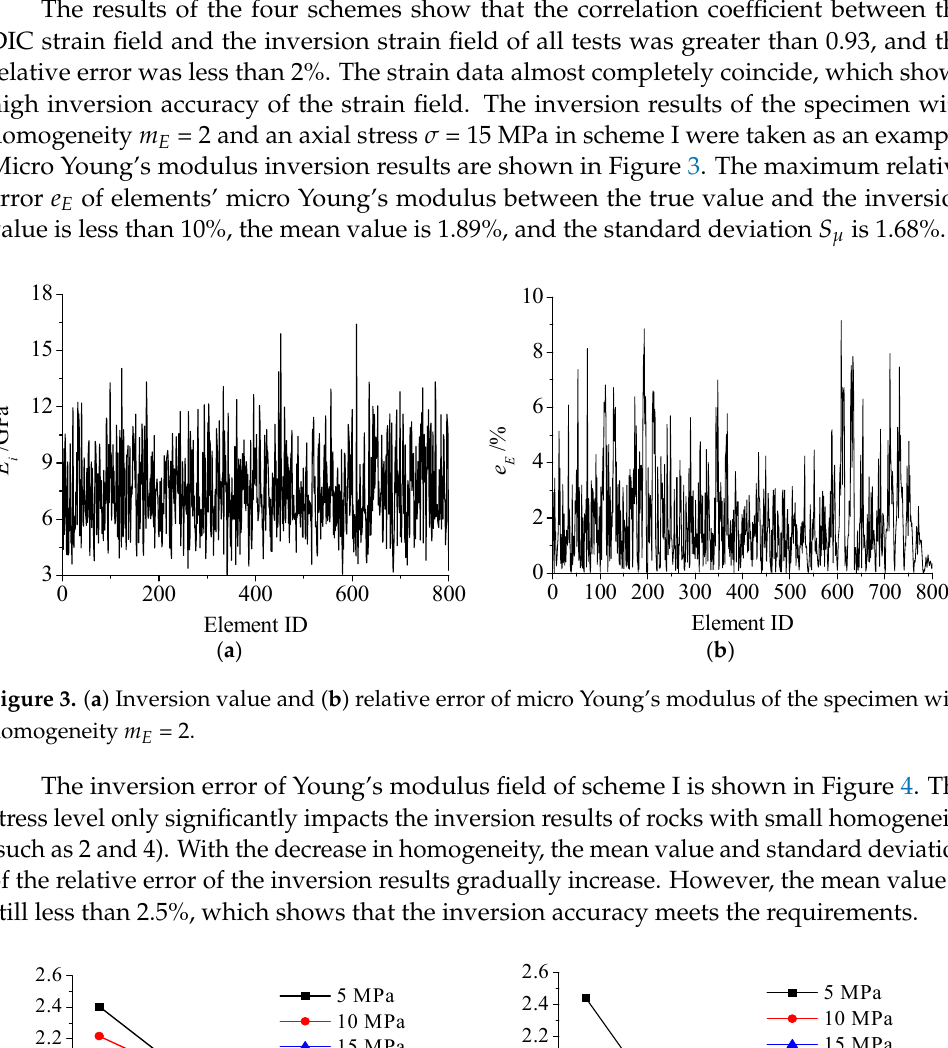
e E % Figure 5. Statistics of the inversion error of Young’s modulus field of scheme III.